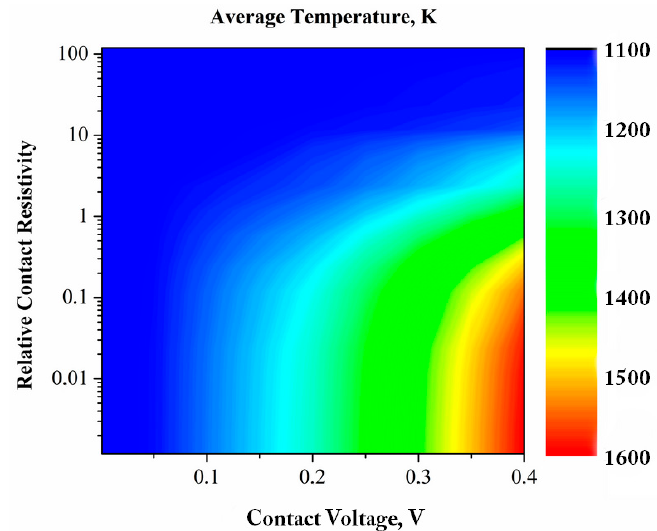
Figure 4. Parametric isolines of the average temperature obtained by modeling of resistance heating of spherical copper particles 10 μ m in diameter covered with oxide films. Reprinted from Olevsky & Dudina [15], Copyright (2018), with permission of Springer Nature.